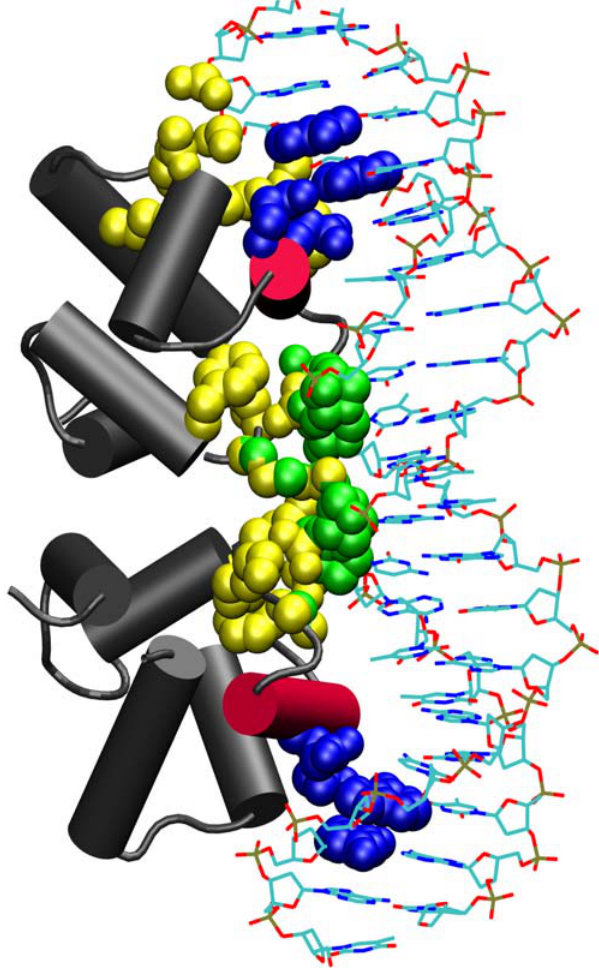
Figure 6. Clusters (P-p, P-S, and P-B) from the 434 repressor protein of the HTH group. The P-p (yellow), P-S (green), and P-B (blue) clusters are shown in the bacteriophage 434 repressor protein (1rpe) which belongs to the HTH group. The P-B clusters are present in the recognition helix that interacts with the major groove of the DNA and the P-p and the P-S clusters are present in the other interacting region that interacts with the minor groove.